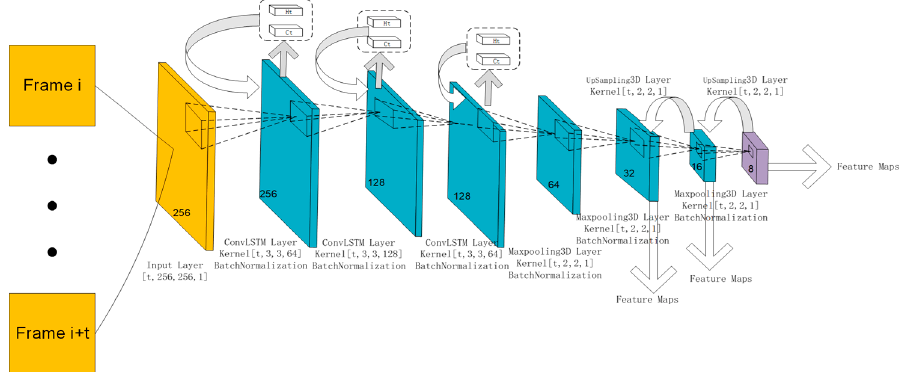
Figure 6. Details of the network’s design. Parameter t is the length of the input sequence. H t is the output of the single cell of Conv-LSTM, and C t is the status of the single cell. The outputs are multiple scale feature maps.